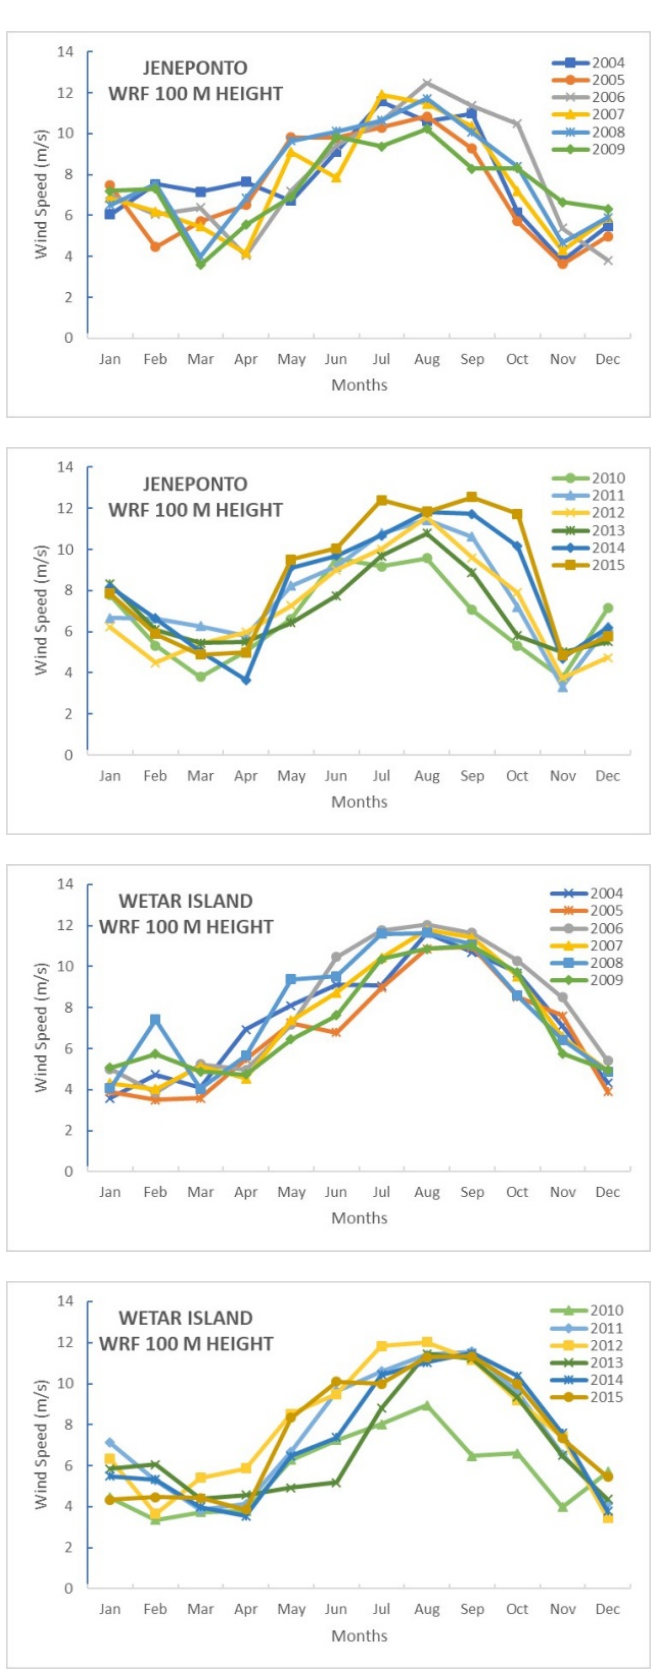
Figure A1. Monthly average wind speed between 2004 and 2015 in the seven evaluated